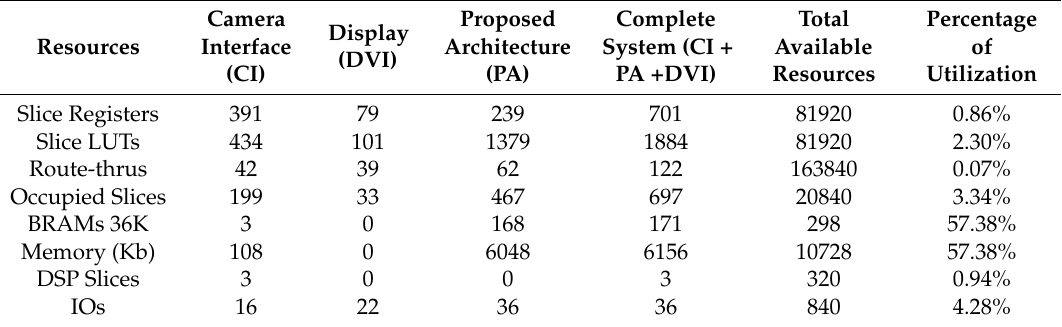
Table 1. FPGA Resource Utilization by Clustering based Motion Detection System.